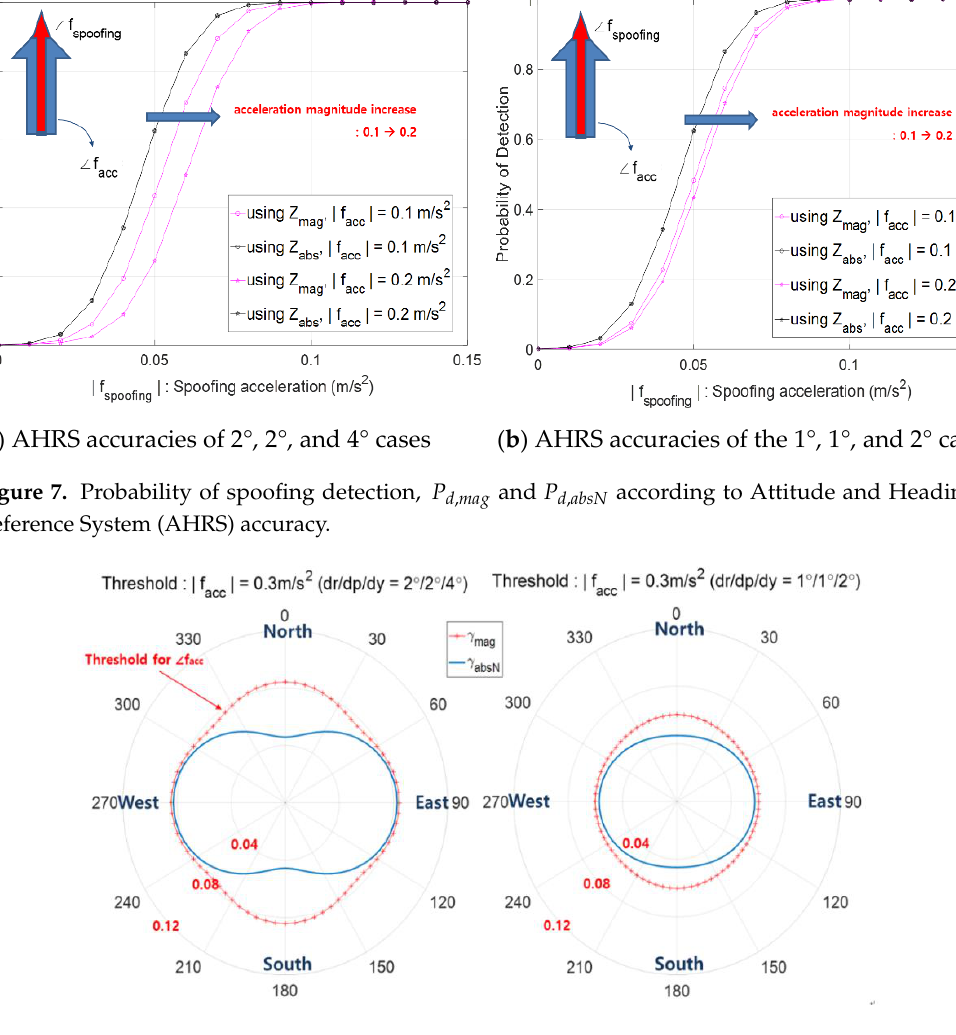
Figure 8. Comparison of spoofing detection threshold according to AHRS accuracy - the angles denote the direction of 𝒇 𝒂𝒄𝒄 , i.e., ∠ 𝒇 𝒂𝒄𝒄 .